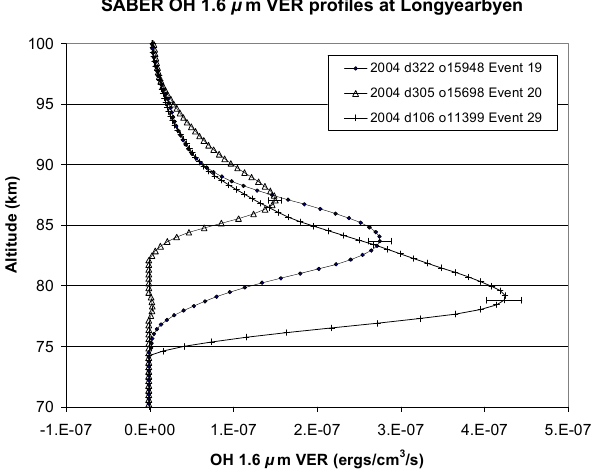
Fig. 1. SABER OH 1.6 µ m VER profiles representative of Longyearbyen (78 ± 5 ◦ N, 16 ± 10 ◦ E) in the period 2002–2008. Representative error bars of ± 5% of the maximum in each profile are included. This is the estimated systematic error quoted for OH VER profiles in the altitude range 70–90km (L´opez-Puertas et al., 2004).